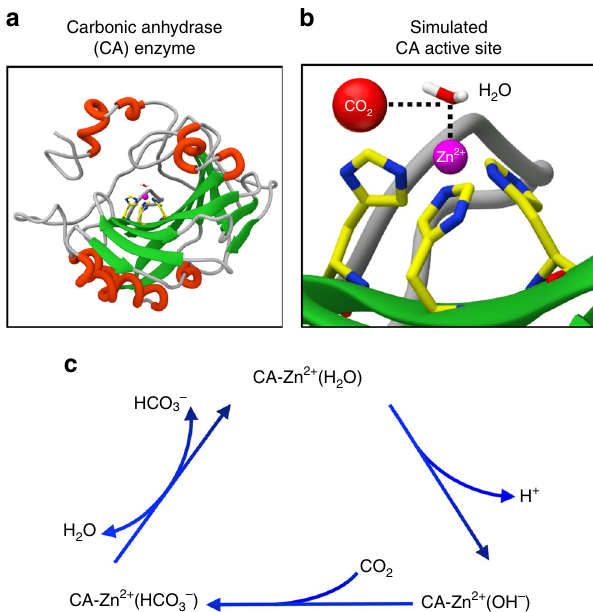
Fig. 1 Carbonic anhydrase enzyme and its CO 2 capture and regeneration mechanism. a Ribbon representation of the carbonic anhydrase (CA) enzyme. b Active site of CA determined by molecular simulations (vide infra). A zinc ion (Zn 2 + ) surrounded by three coordinating histidines and a water molecule comprises the active site. c Depiction of the overall